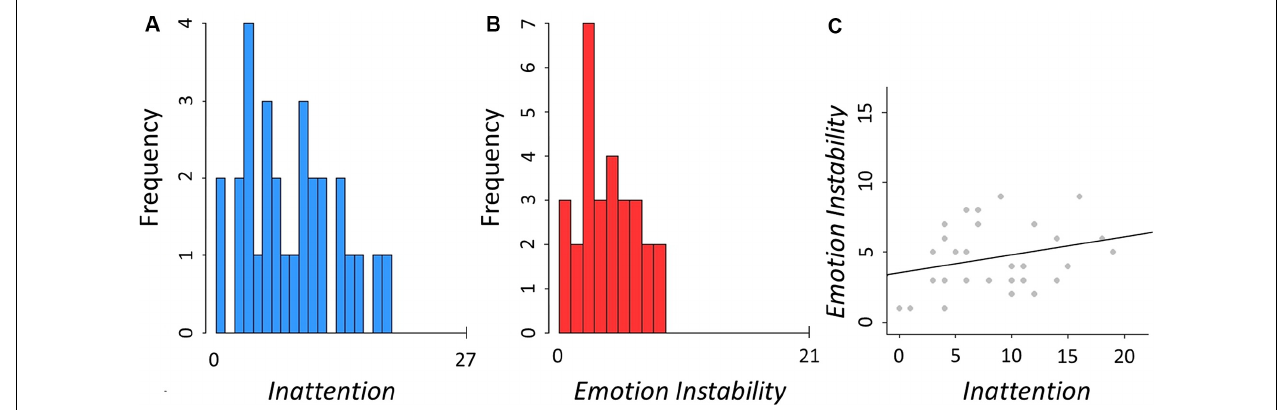
FIGURE 2 | Descriptives of the assessed traits. (A) Distribution of B-ADD Inattention , mean = 8.59 (SD = 5.03, min = 0, max = 19). (B) Distribution of B-ADD Emotion Instability , mean = 4.59 (SD = 2.37, min = 1, max = 9). (C) Correlation between Inattention and Emotion Instability ( r = 0.27, p = 0.16).